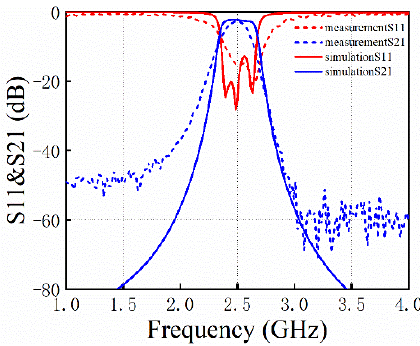
Figure 9. Simulation and measurement results of the proposed filter.